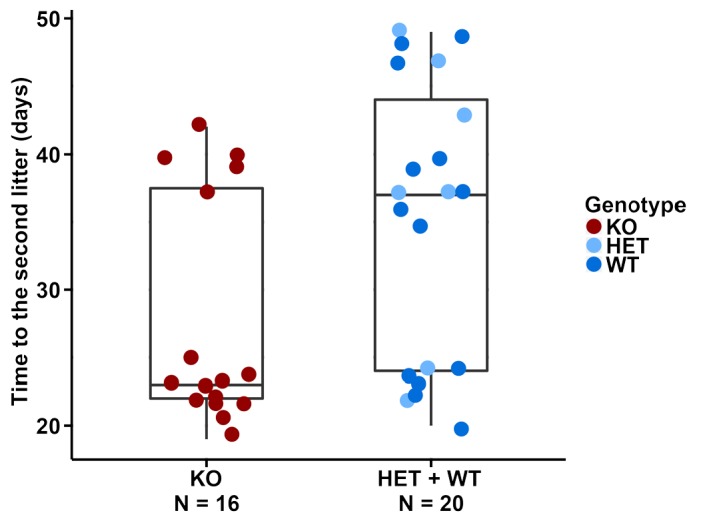
Distributions of the time from the first litter to the second litter.Time points of the second litter are plotted for the different genotypes, with box plots marked. A bimodal distribution becomes evident, as discussed in the text.10.7554/eLife.44392.016Figure 5—source data 1.Details of the fertility scores for the different groups of mice.The mice listed under the UC codes are part of the standard stock breeding, the mice listed under the WT and KO codes were specifically set up to confirm the observations from the stock breeding.